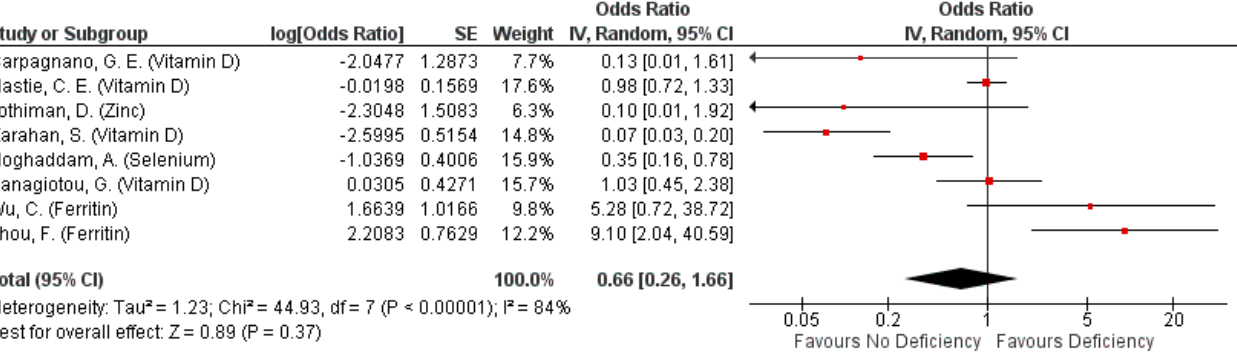
Figure 3. Pooled odds ratio on mortality from COVID-19 episode, or during hospitalisation due to COVID-19 episode when hospitalized subjects are not deficient, compared to those deficient in any micronutrient singly.